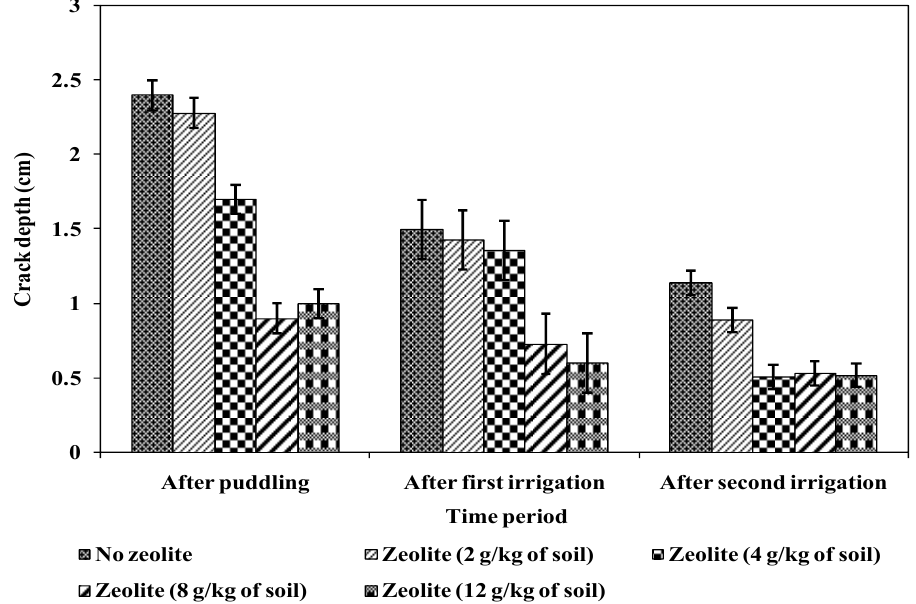
Figure 7. Effect of Zeolite on Crack Depth in Puddled Transplanted Rice. Modified from Razmi and Sepaskhah [61].